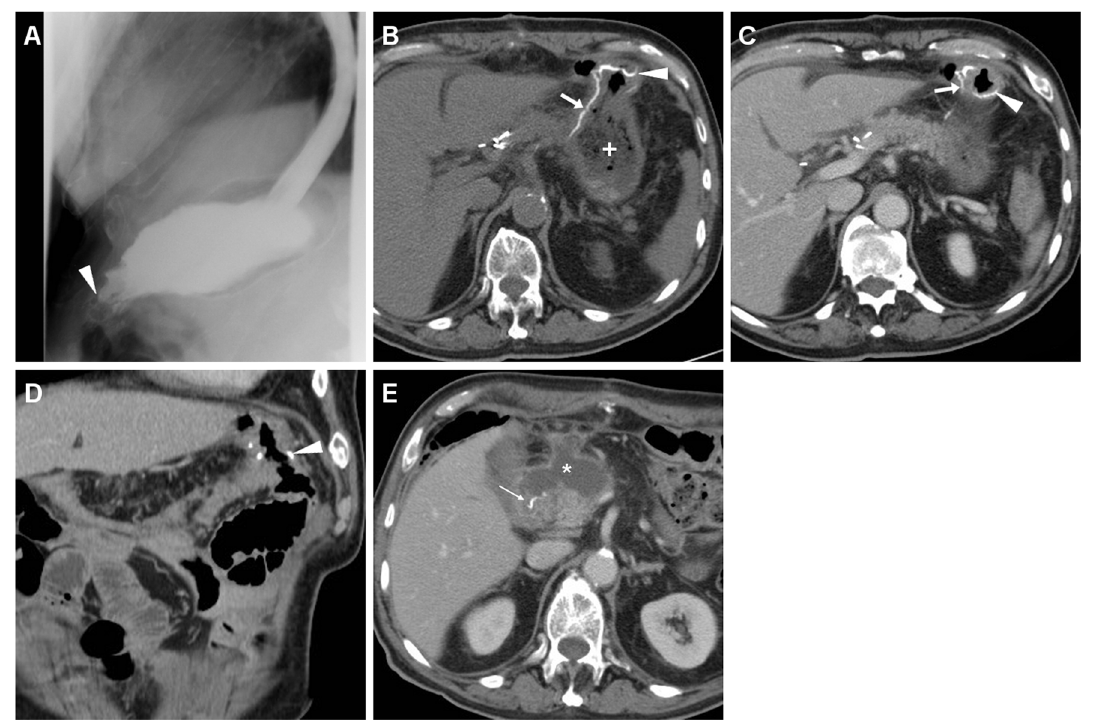
Fig. 6 A 78-year-old male with antral gastric cancer underwent subtotal gastrectomy with D2 lymphadenectomy and Billroth II reconstruction and suffered from postoperative vomiting and fever. On 5th POD CF (A) showed limited, slow transit through the GJS (arrowhead). On 9th POD, unenhanced (B) and post-contrast (C-E) CTshowed stapled gastric